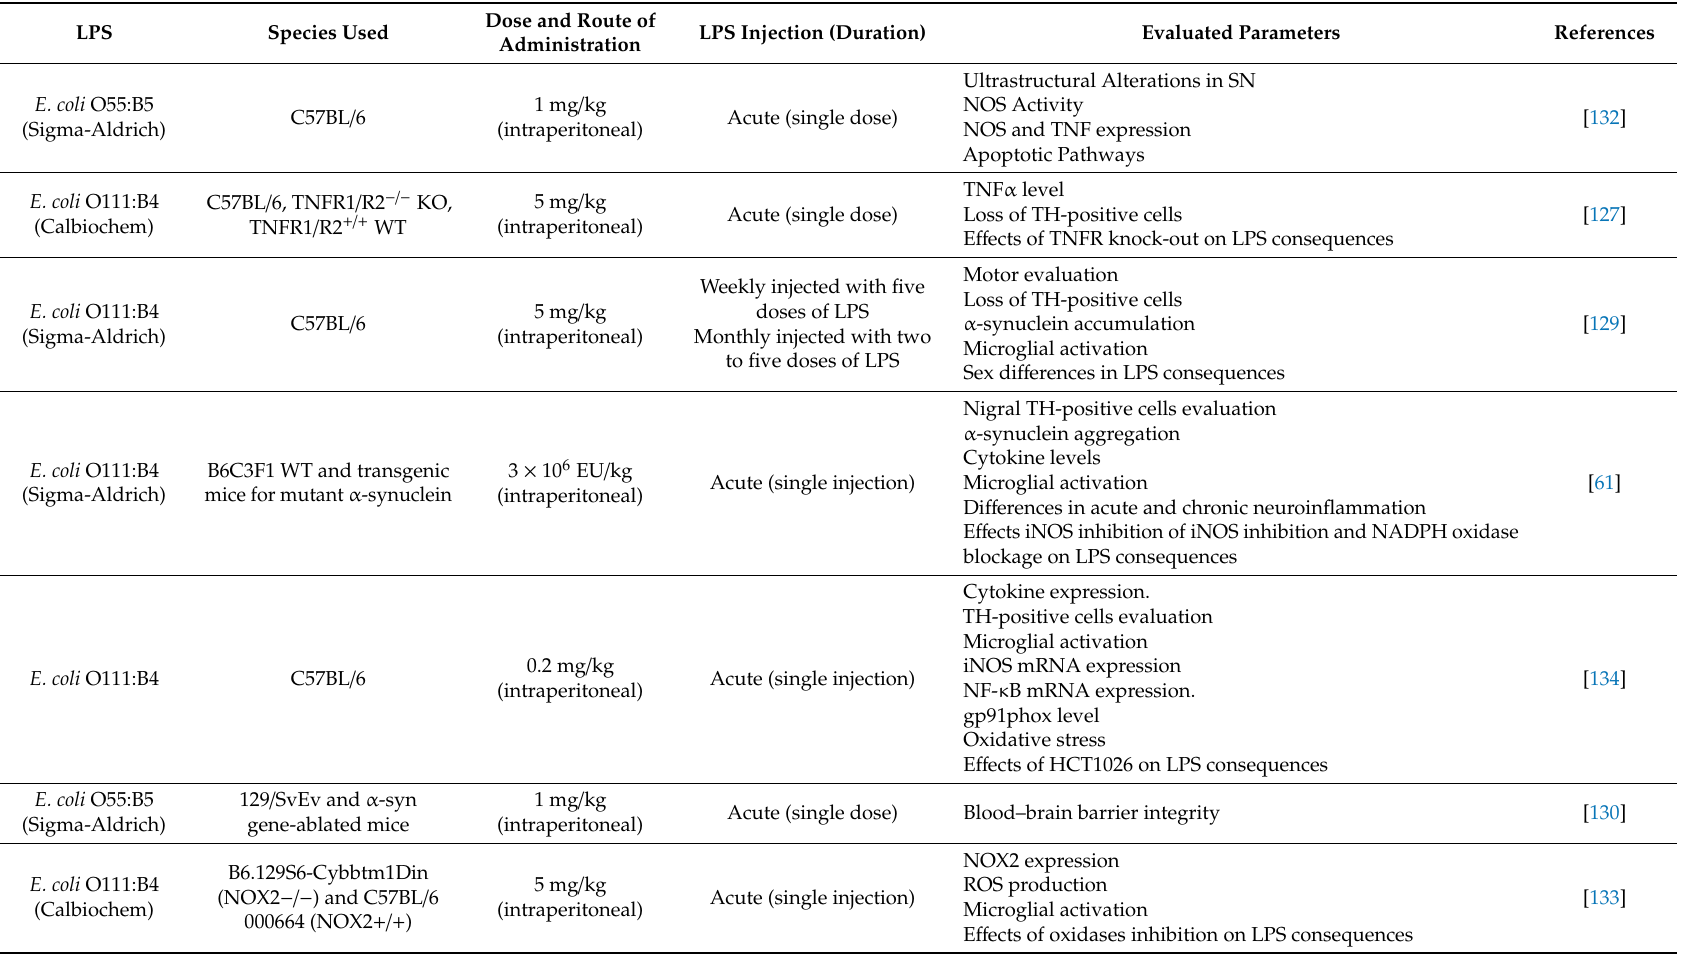
Table 4. LPS source, species used, dose and route of administration, duration, evaluated parameters of models of systemic LPS challenges for the elucidation of